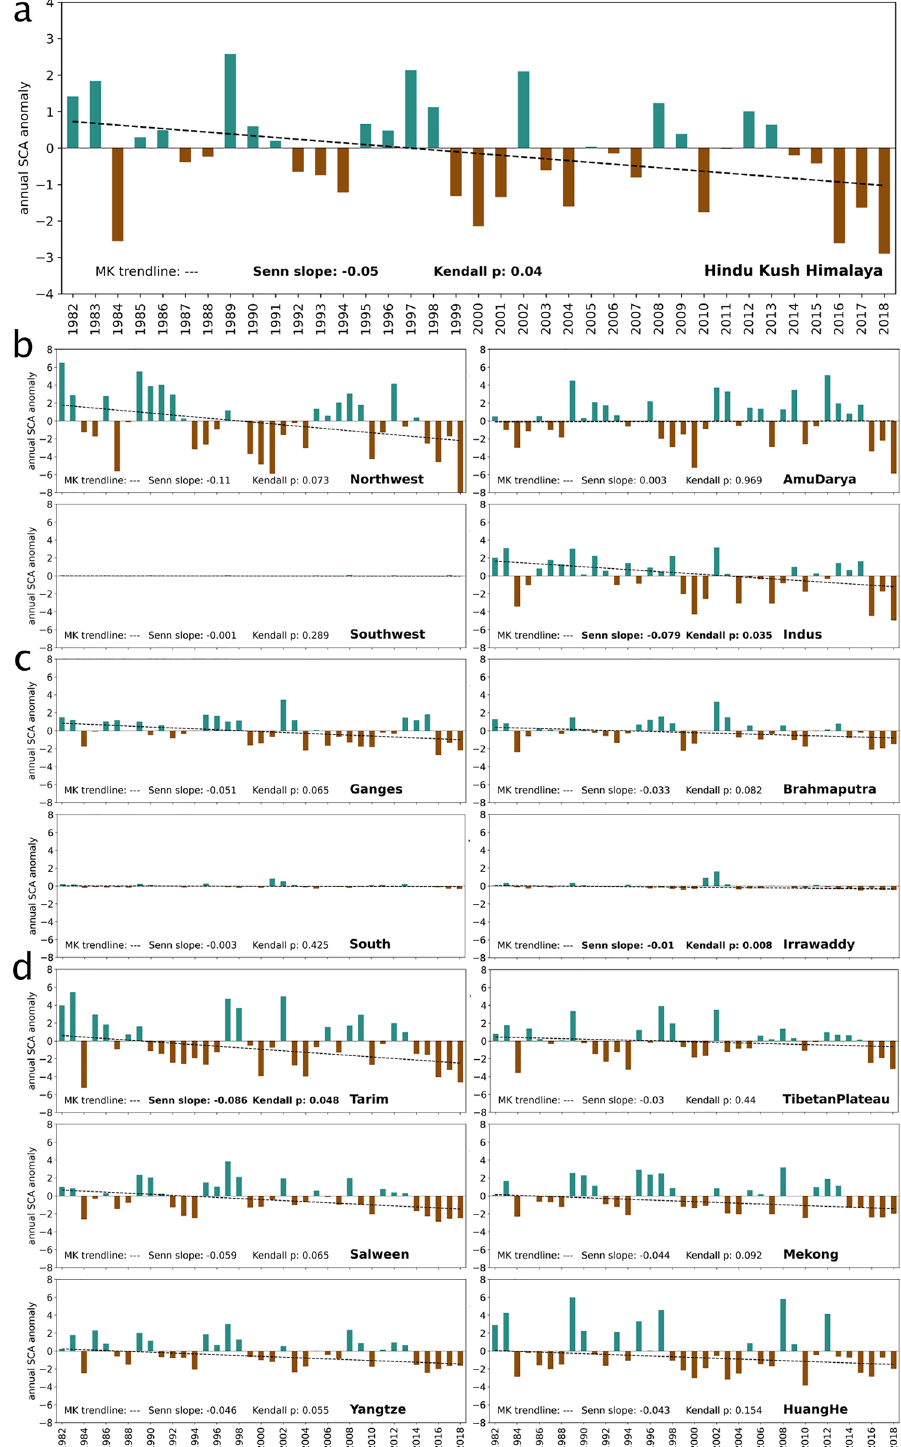
Figure 4. Interannual and spatial variability in snow cover extent. Annual SCA % anomalies for the entire HKH region ( a ), or one of the 14 basins; arranged in greater regions west ( b ), central ( c ) and east ( d ), with respect to the 1982–2010 reference period. Note different y-axis range for the top HKH region figure. Dashed lines denote the MK trendline and statistics (Senn slope and Kendall p) are given at the bottom of each graph. All numeric details can be found in the Supplementary Table